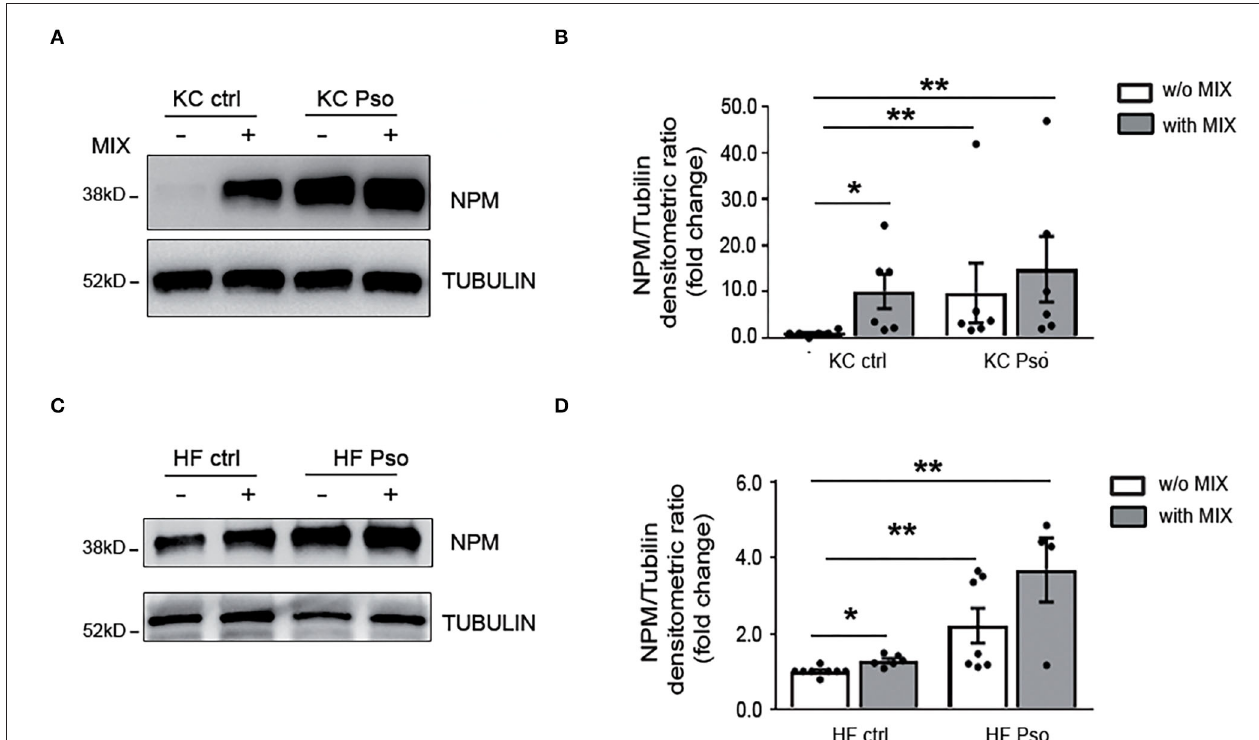
FIGURE 2 | Psoriasis and inflammatory stimuli increased NPM protein levels in both KCs and HFs. Primary human keratinocytes (KCs) and human fibroblasts (HFs) were isolated from NLS of Pso and HS as control. KCs and HFs were treated for 8h with a MIX of cytokines (IL-17A, IL-22, TNF α , and IFN- γ ). Afterward, NPM protein levels were evaluated by Western blot analysis (WB). (A) Representative WB using NPM antibody showed that NPM protein expression was increased in KCs treated with the cytokine MIX and in KCs isolated from NLS of Pso compared to HS. (B) Densitometric analysis of NPM normalized by α -tubulin protein expression levels ( n = 6; * p < 0.05, ** p < 0.01). (C) NPM protein expression was increased in HFs isolated from NLS of Pso and in control KCs treated with the cytokine MIX compared to HS. (D) Densitometric analysis of NPM normalized by α -tubulin protein levels ( n = 6; * p < 0.05, ** p <